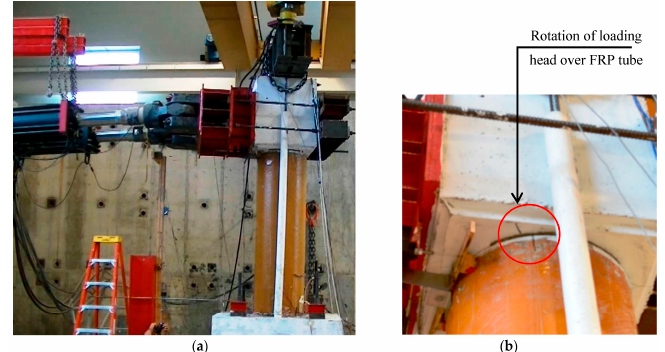
Figure 8. The column under torsional loading: ( a ) column’s profile and ( b ) slip of the loading head over the GFRP tube at a twist angle of 9°.